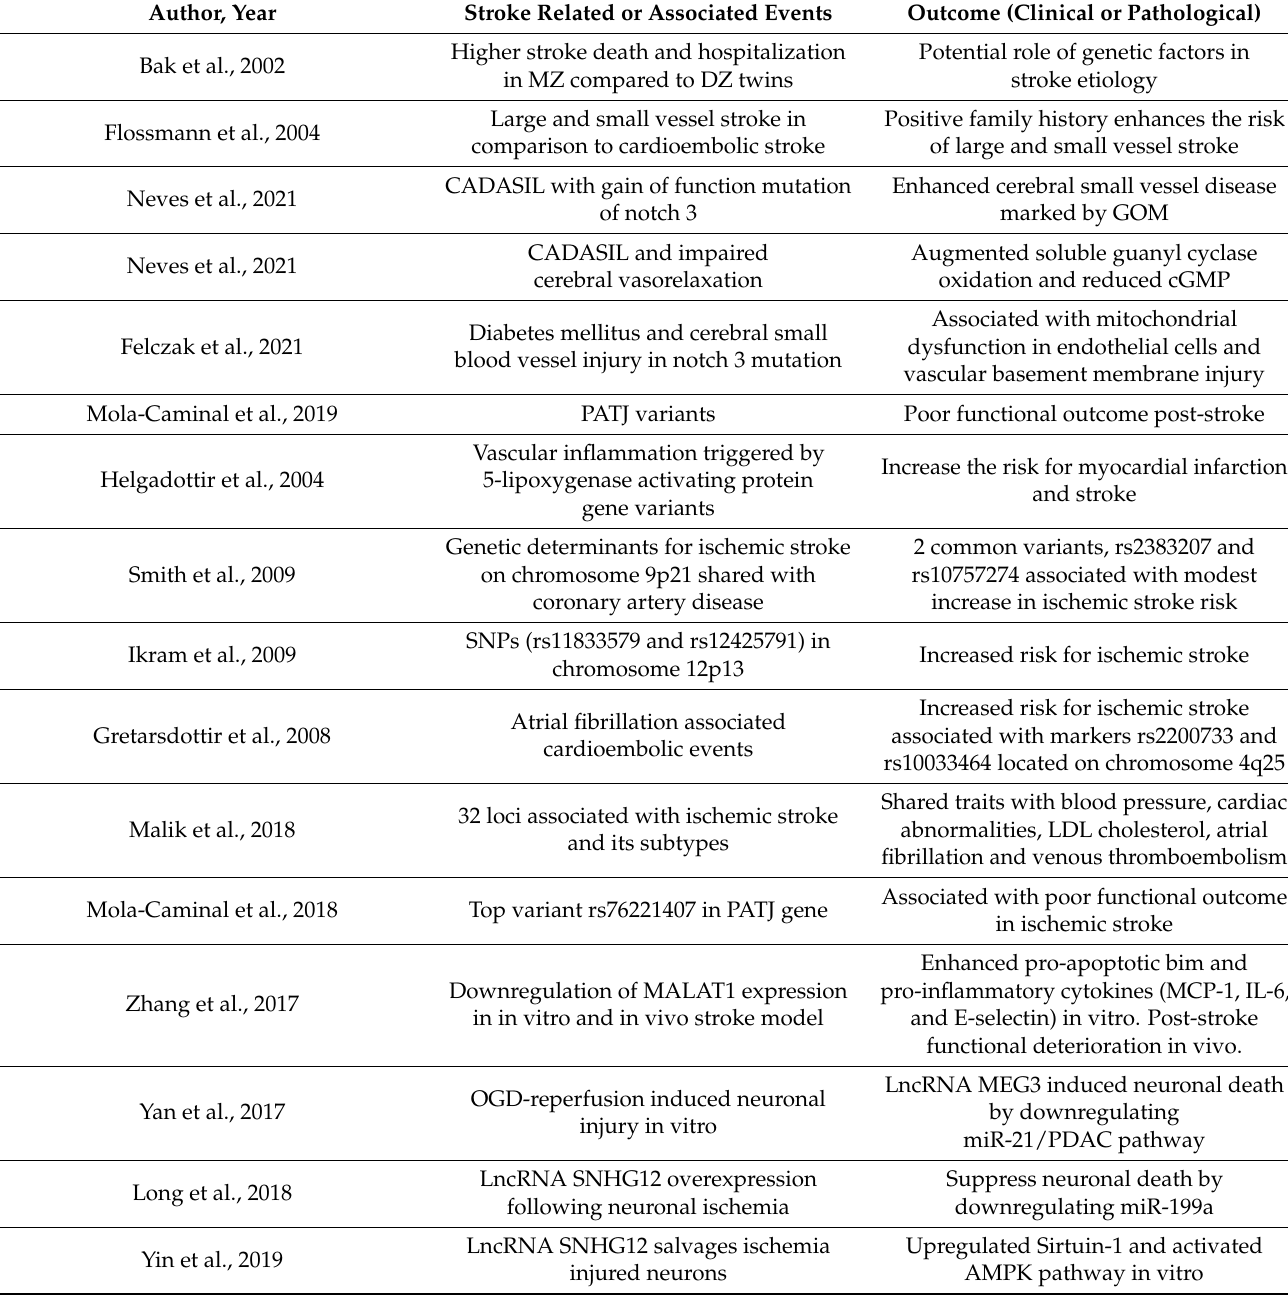
Table 1. Studies showing stroke related events and clinical or pathological